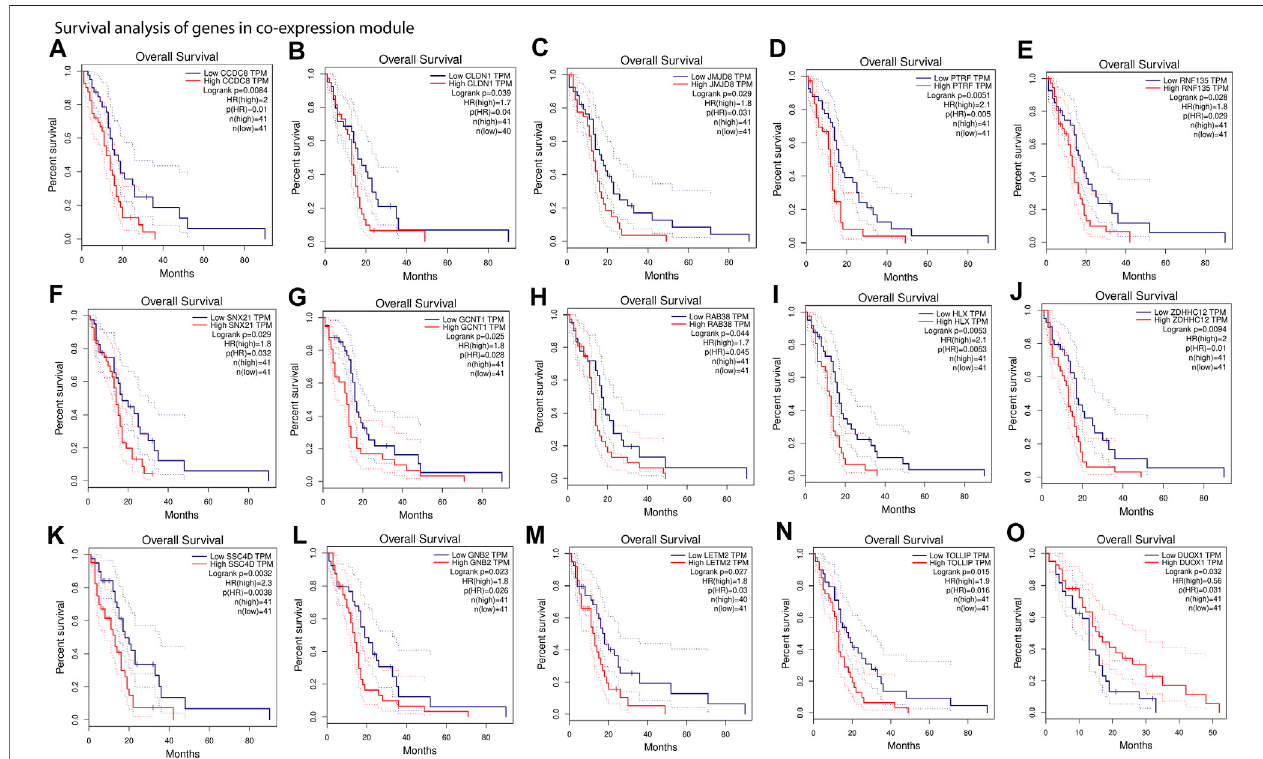
FIGURE 5 | Survival analysis of gene present in co-expression module. (A – F) , Kaplan – Meier plots of genes from positively associated modules with the classical subtype. (G – M) , Kaplan – Meier plots of genes from positively associated modules with the mesenchymal subtype. (N,O) , Kaplan – Meier plots of genes from positively associated modules with the proneural subtype. Overall survival was analyzed based on the clinical information of the patients from TCGA and quartile method of 75% cutoff of higher and 25% cutoff of lower limit (An extended version of this fi gure is provided in Supplementary Figure S3 ).